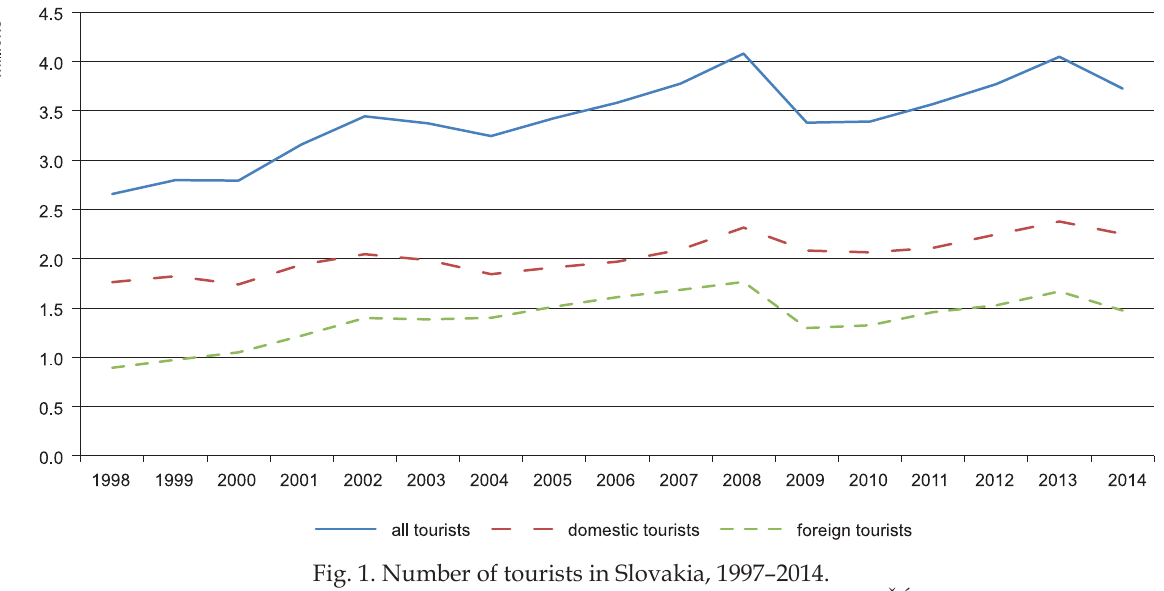
Fig. 1. Number of tourists in Slovakia,